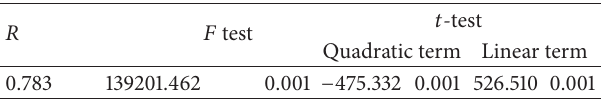
Table 1: Significance test of traffic flow-density quadratic regression model on median lanes. 𝑅 𝐹 test